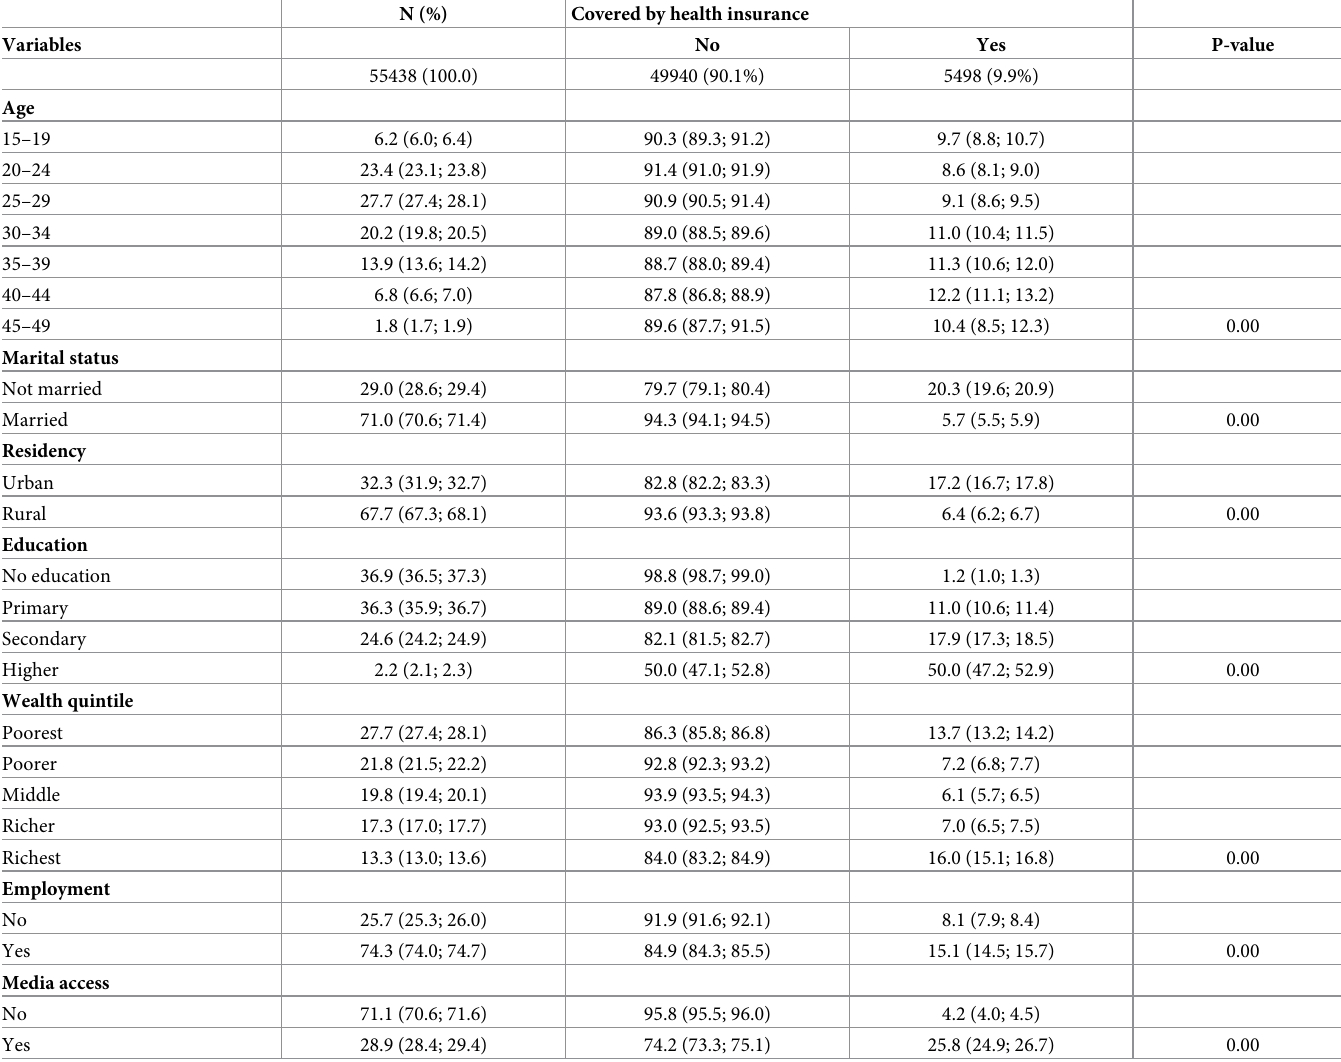
Table 2. Health insurance ownership by sociodemographic characteristics. (n = 55,438).